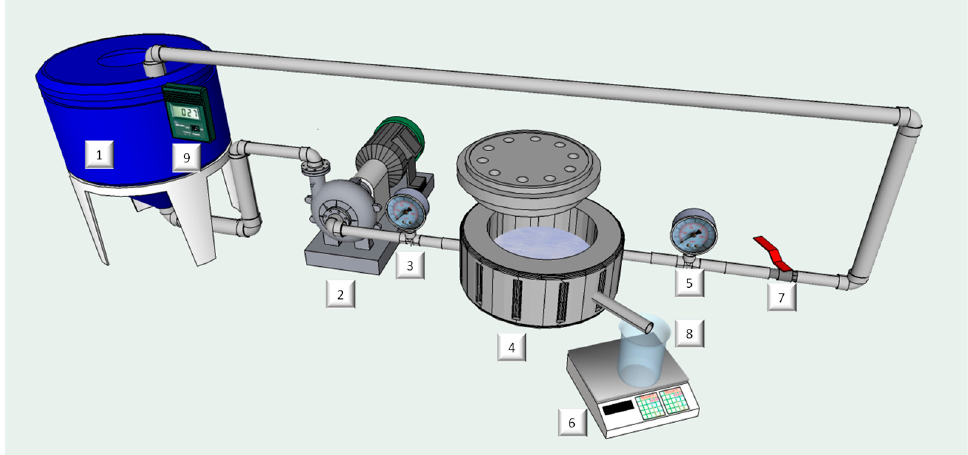
Figure 1. Schematic diagram of the experimental set-up: (1) feed tank; (2) feed pump; (3,5) pressure gauges; (4) flat-sheet cell; (6) digital balance; (7) retentate valve; (8) permeate tank; and (9) thermometer. Table 2. Characteristics of selected membranes.